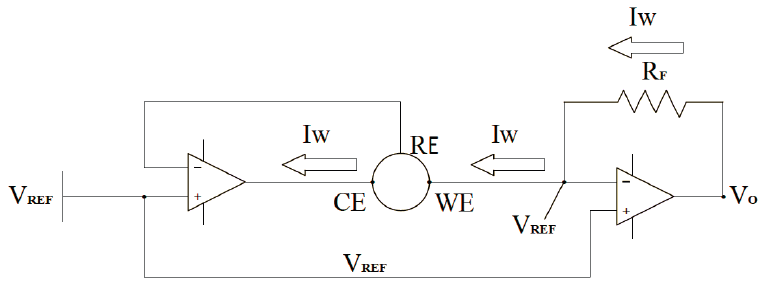
Figure 3. The brief circuit diagram in the glucose sensing device with two amplifiers, the working (WE), counter (CE), and reference (RE) electrodes for glucose